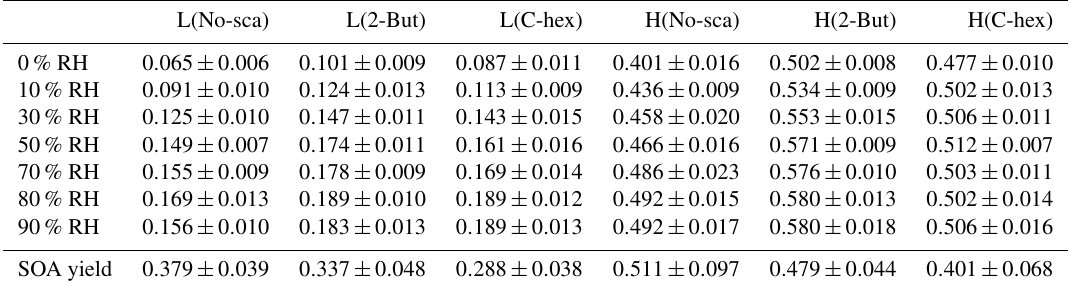
Table 3. The SOA yield and mass fraction of particulate peroxides at a low or high [O 3 ] / [limonene] ratio in the presence or absence of the OH scavenger from 0% to 90% relative humidity